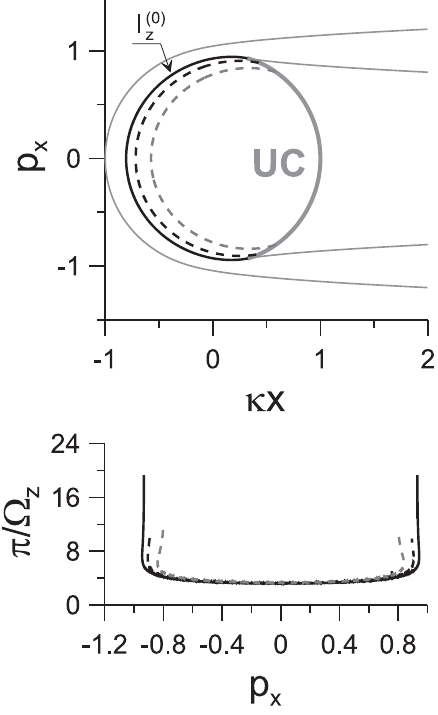
Fig. B2. Fragments of three trajectories and corresponding depen- dence of π/(cid:127) z on p x